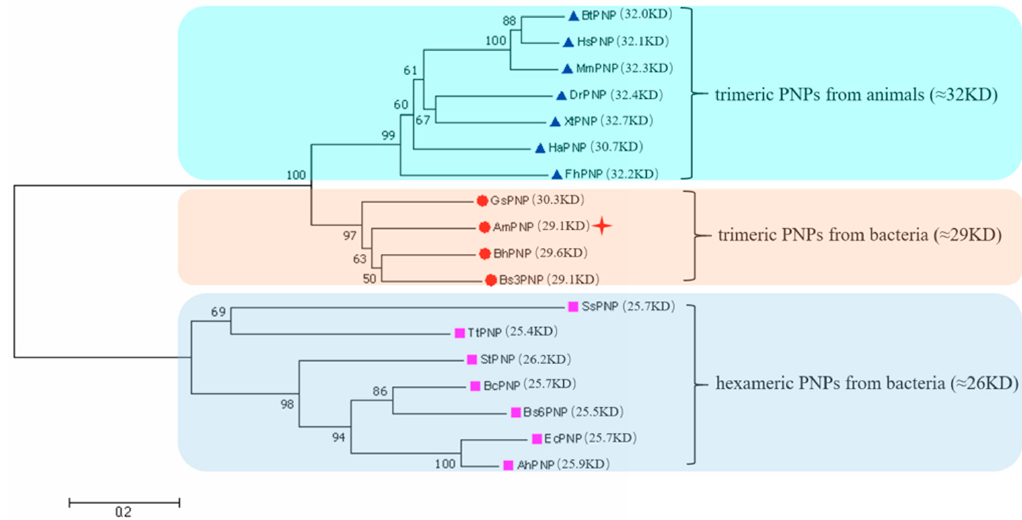
Figure 1. Phylogenetic analysis of purine nucleoside phosphorylases (PNPs). Ah PNP